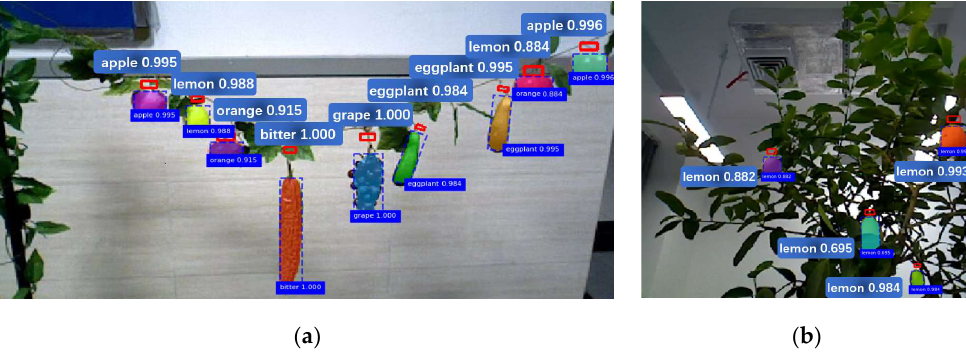
Figure 10. Results of the cutting-point-detection for some plastic ( a ) and real crops ( b ).